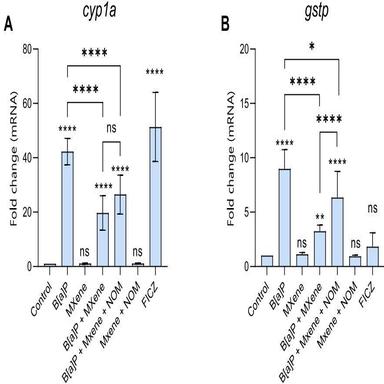
mRNA expression of (A) cyp1a and (B) gstp in zebrafish embryos after 24 h of exposure to BP (1 mg/L) in the presence or absence of MXenes (80 mg/L) with or without the addition of NOM (10 mg/L). FICZ (1 μM) was used as a positive control. Data are presented as mean values ± S.D. of three independent experiments (30 embryos per experiment). One-way ANOVA with Tukey's multiple comparison test was used to analyze statistical differences between the exposures (p < 0.05, p < 0.01, p < 0.001, p < 0.0001).